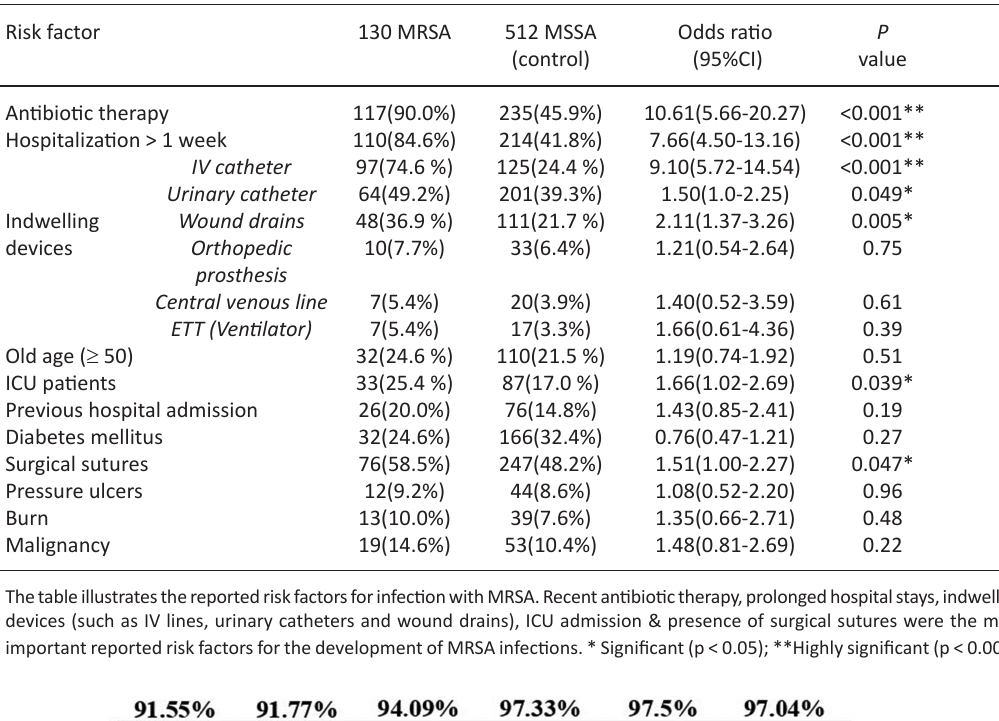
Table 1. The risk factors for methicillin resistance among Staphylococcus aureus isolates